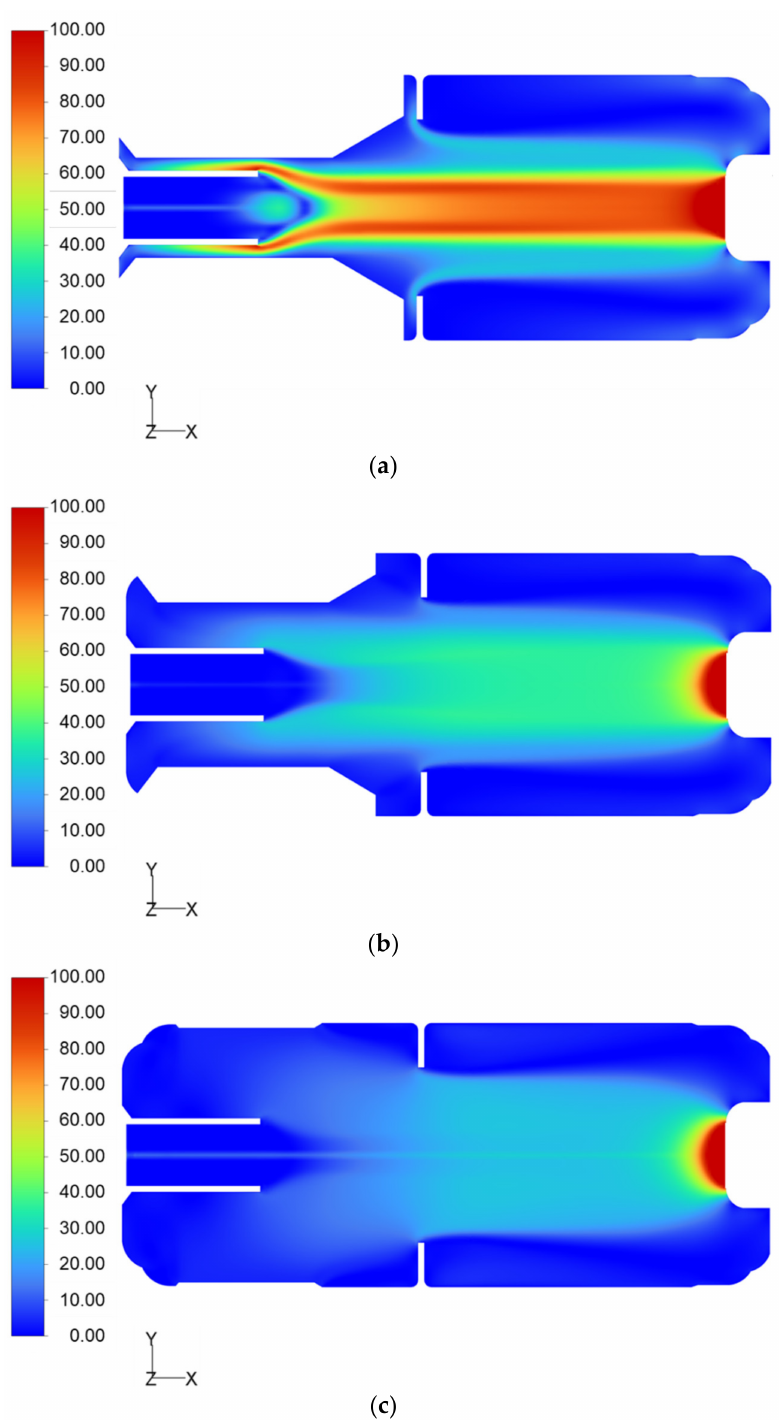
Figure 6. The velocity (m/s) of the gas phase in I pulse combustion chamber at different times: ( a ) t = 2 s; ( b ) t = 7 s; ( c ) t = 14